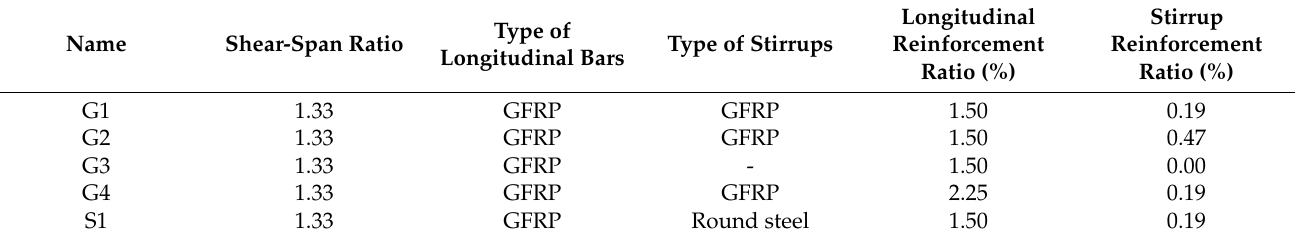
Table 2. Detailed parameters of concrete short columns.